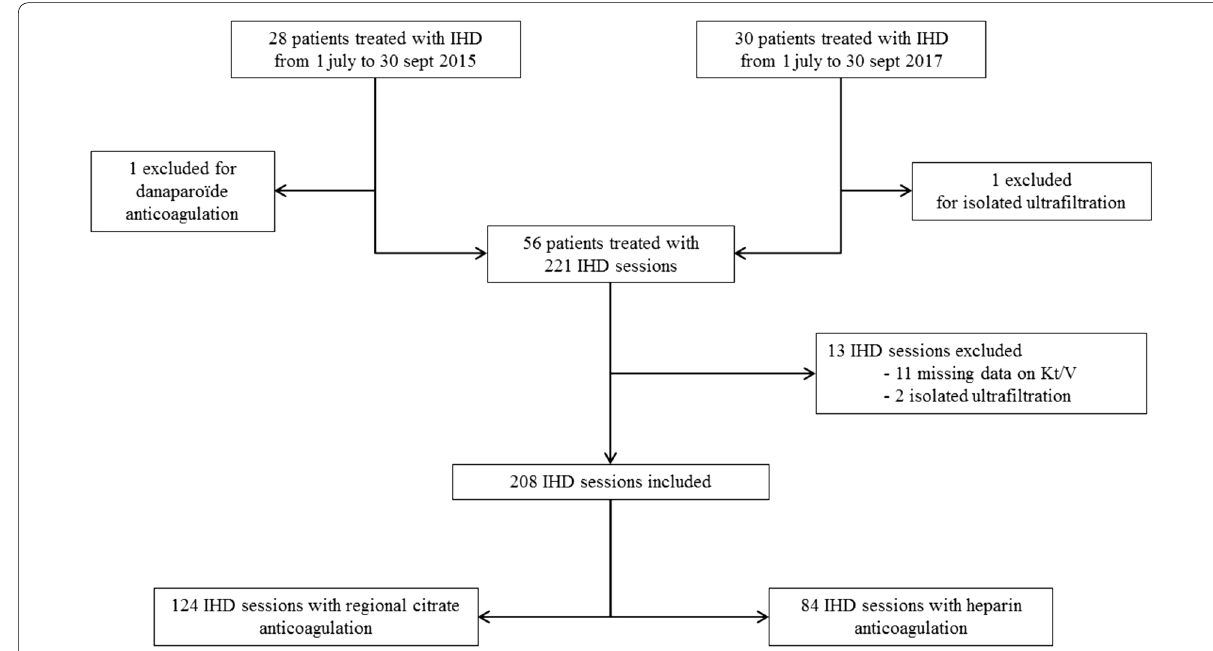
Fig. 1 Flowchart of patients treated with intermittent hemodialysis in 2015 and 2017. IHD intermittent